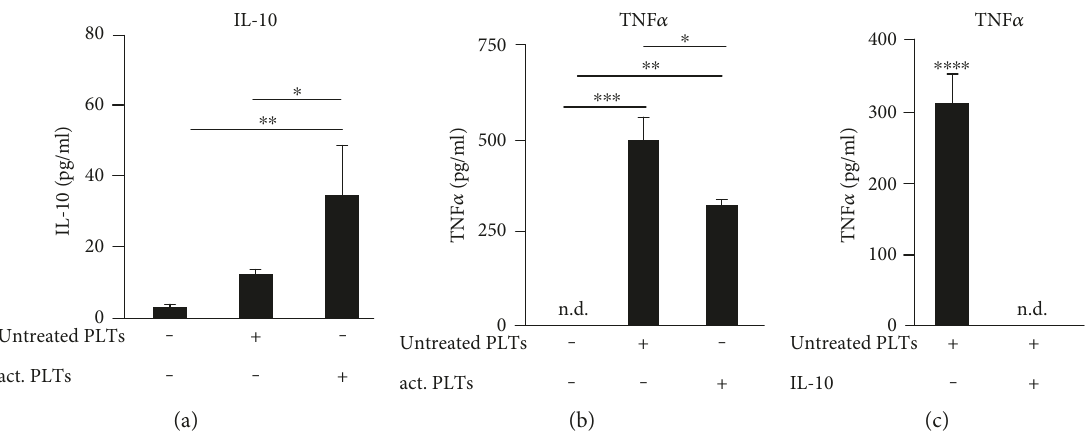
Figure 1: Collagen-activated platelets selectively regulate the synthesis of IL-10 and TNF α in cocultures with murine macrophages. (a), (b) Murine bone marrow-derived macrophages (BMDM) were incubated alone, with untreated platelets (untreated PLTs) or with platelets prestimulated with collagen (1 μ g/ml; act. PLTs) for 3 hours and the concentrations of IL-10 and TNF α were determined by ELISA. (c) Murine BMDM were incubated with untreated platelets with or without murine IL-10 (125pg/ml). TNF α levels were determined in the medium. Data are presented as mean ± SEM from 4 experiments. One-way ANOVA/Bonferroni ∗ P < 0 05 , ∗∗ P < 0 01 , ∗∗∗ P < 0 002 , ∗∗∗∗ P < 0 0004